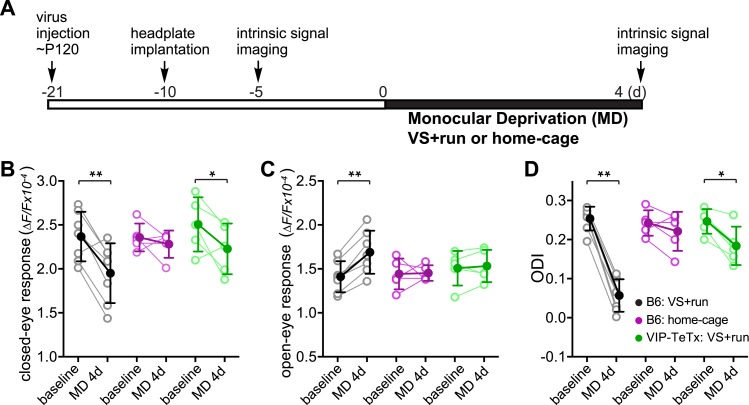
Synaptic transmission from VIP neurons facilitates the enhancement of ocular dominance plasticity in adult mice by running.(A) Experimental schedule. (B and C) Amplitudes of intrinsic signal responses evoked by the visual stimulation through the closed eye (B) and the open eye (C) before (baseline) and after 4-day monocular deprivation of the contralateral eye (MD 4d). (D) Ocular dominance index (ODI) computed from response amplitude to contralateral (closed) and ipsilateral (open) eyes shown in (B and C). Open circles represent measurements in individual animals. B6: C57BL/6J wild type mice (VS + run: n = 7; home-cage: n = 5); VIP-TeTx: VIP-Cre mice that received a cortical injection of AAV-DIO-TeTx and treated with VS + run during MD (n = 5). Solid circles represent the average of the corresponding open circles or open triangles (±S.D.). *p < 0.05, **p < 0.01 between baseline and after MD 4d; two-way ANOVA followed by multiple comparisons with Bonferroni correction.